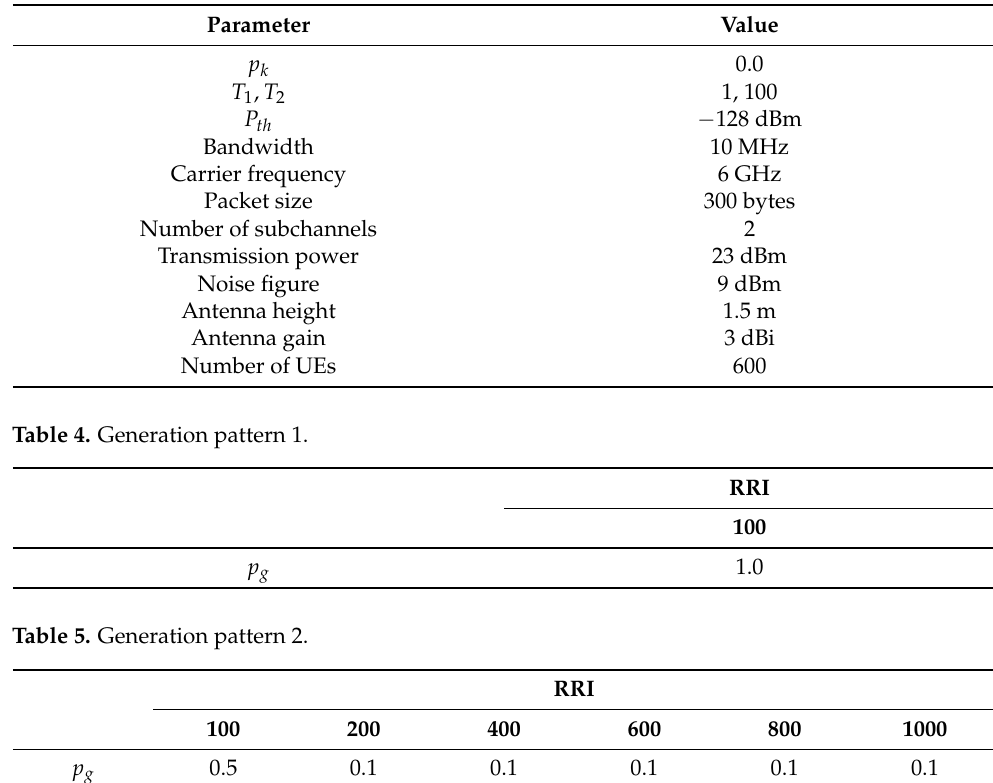
Table 3. Simulation parameters.